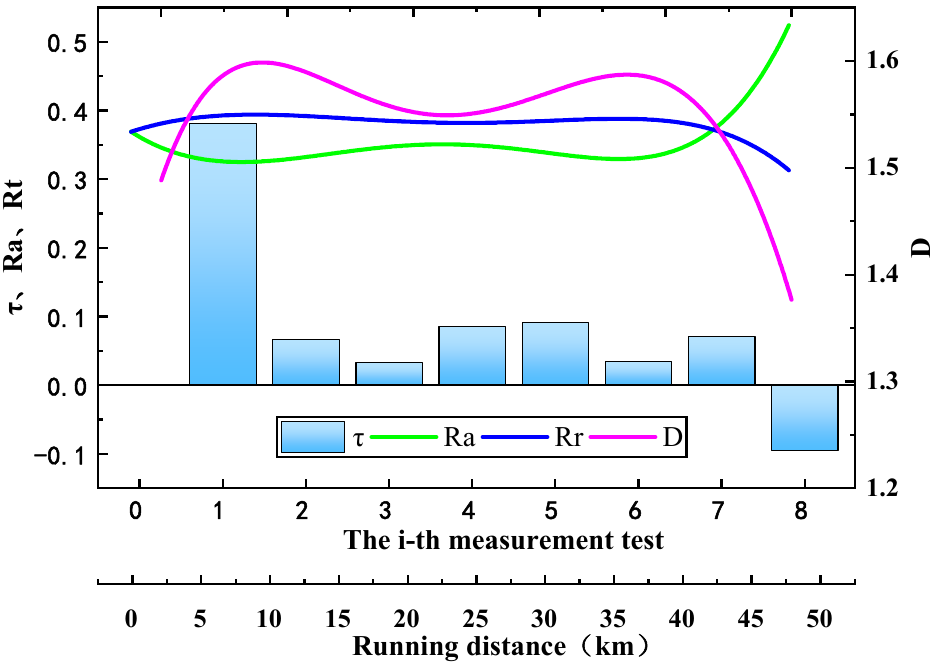
Figure 15. Characteristic parameters of raceway morphology and degradation rate of preload drag force during wear.